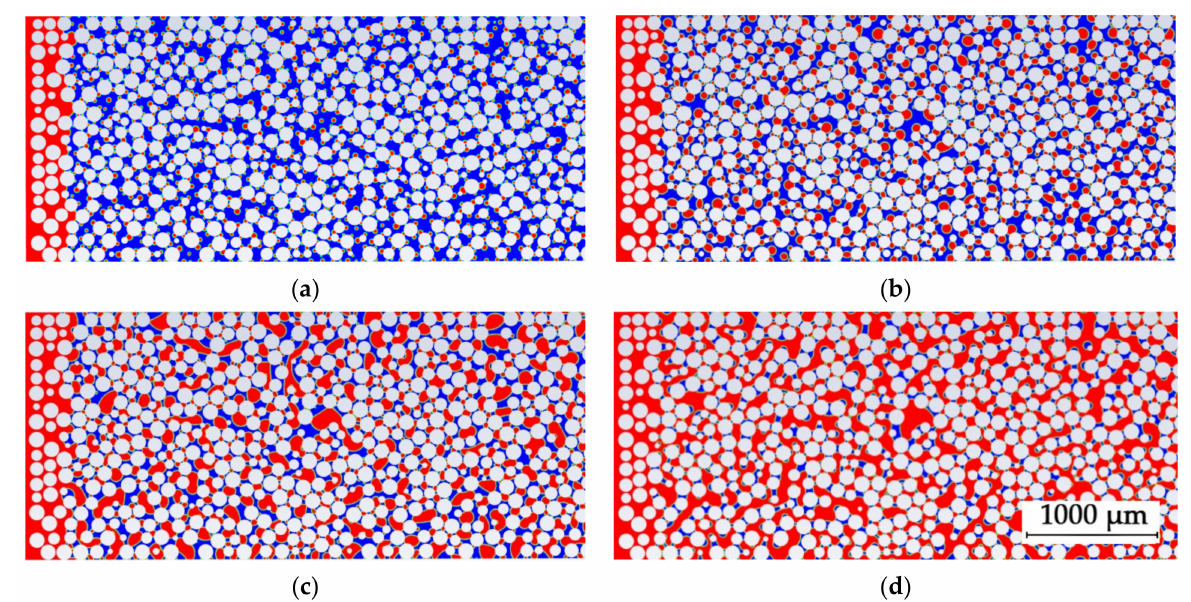
Figure 2. Initial distribution of water and oil in the computational domain: ( a ) Sw = 20%; ( b ) Sw = 40%; ( c ) Sw = 60%; ( d ) Sw = 80%.